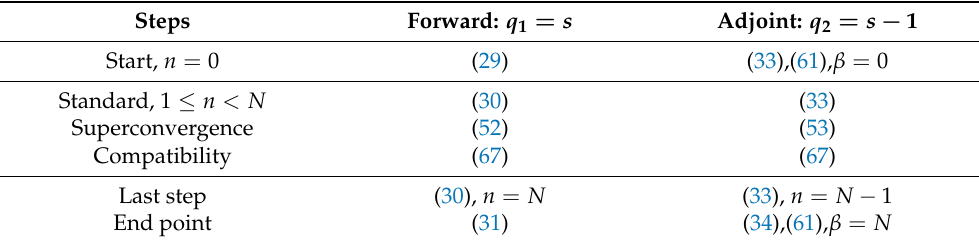
Table 1. Combined order conditions for the Peer triplet, including the compatibility condition (67) and the condition (61) for full matrices K N